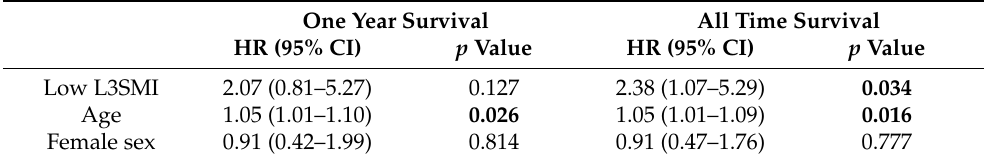
Table 3. Association with survival—Multivariate